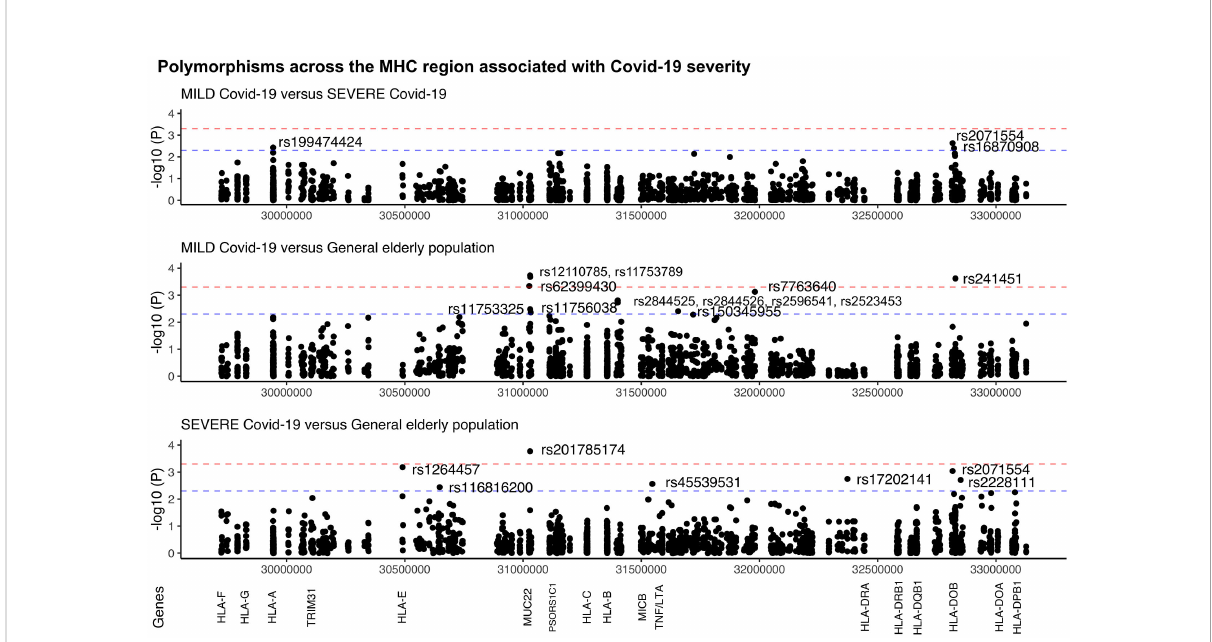
FIGURE 2 Manhattan plot illustrating differences among patients with MILD and SEVERE Covid-19, and the general elderly population from the same city. The general elderly population consists of whole-genomes (WGS) of 1,170 elders from São Paulo city, with unknown status regarding Covid-19. We considered only variants with a minor allele frequency of 1% in at least one of the groups, with no more than 5% of missing alleles in both groups, and with a ratio between read depth for each allele in heterozygous sites ranging from 0.3 to 0.5 for Exomes (the MILD and SEVERE groups). The red line marks the threshold for detecting a variant associated with the phenotype by calculating the number of segregation blocks observed in our data. The blue line marks the suggestive threshold for a candidate variant, p < 0.005. Most MUC22 variants are in Linkage Disequilibrium (r 2 >